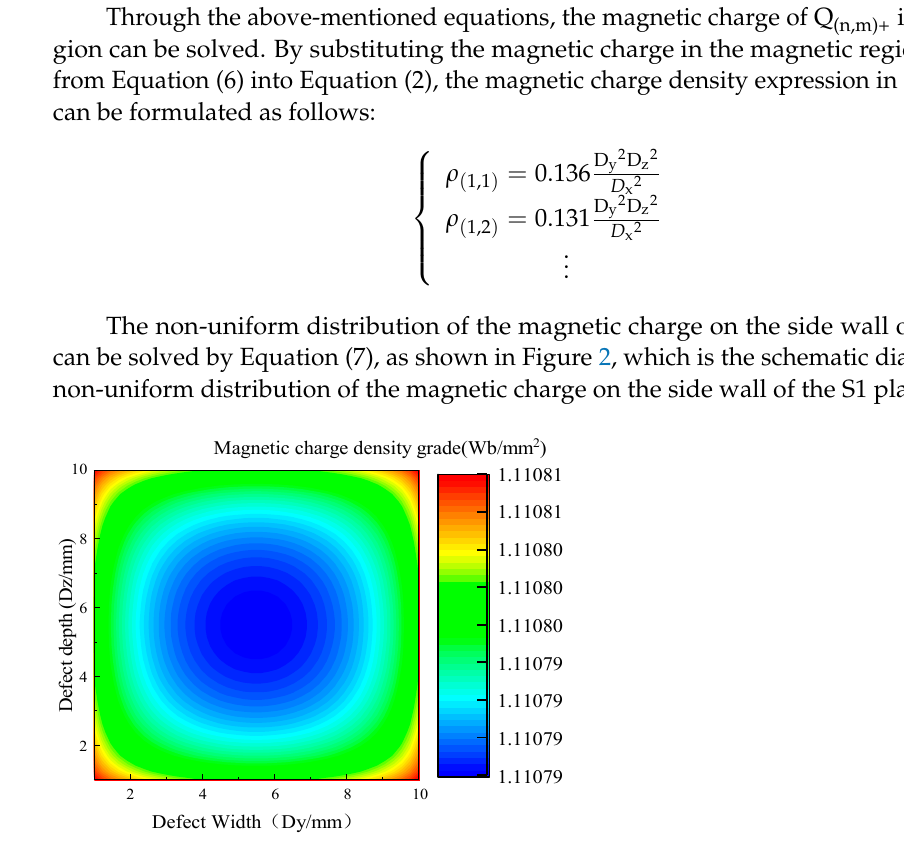
Figure 2. Contour map of non-uniform distribution of magnetic charges .